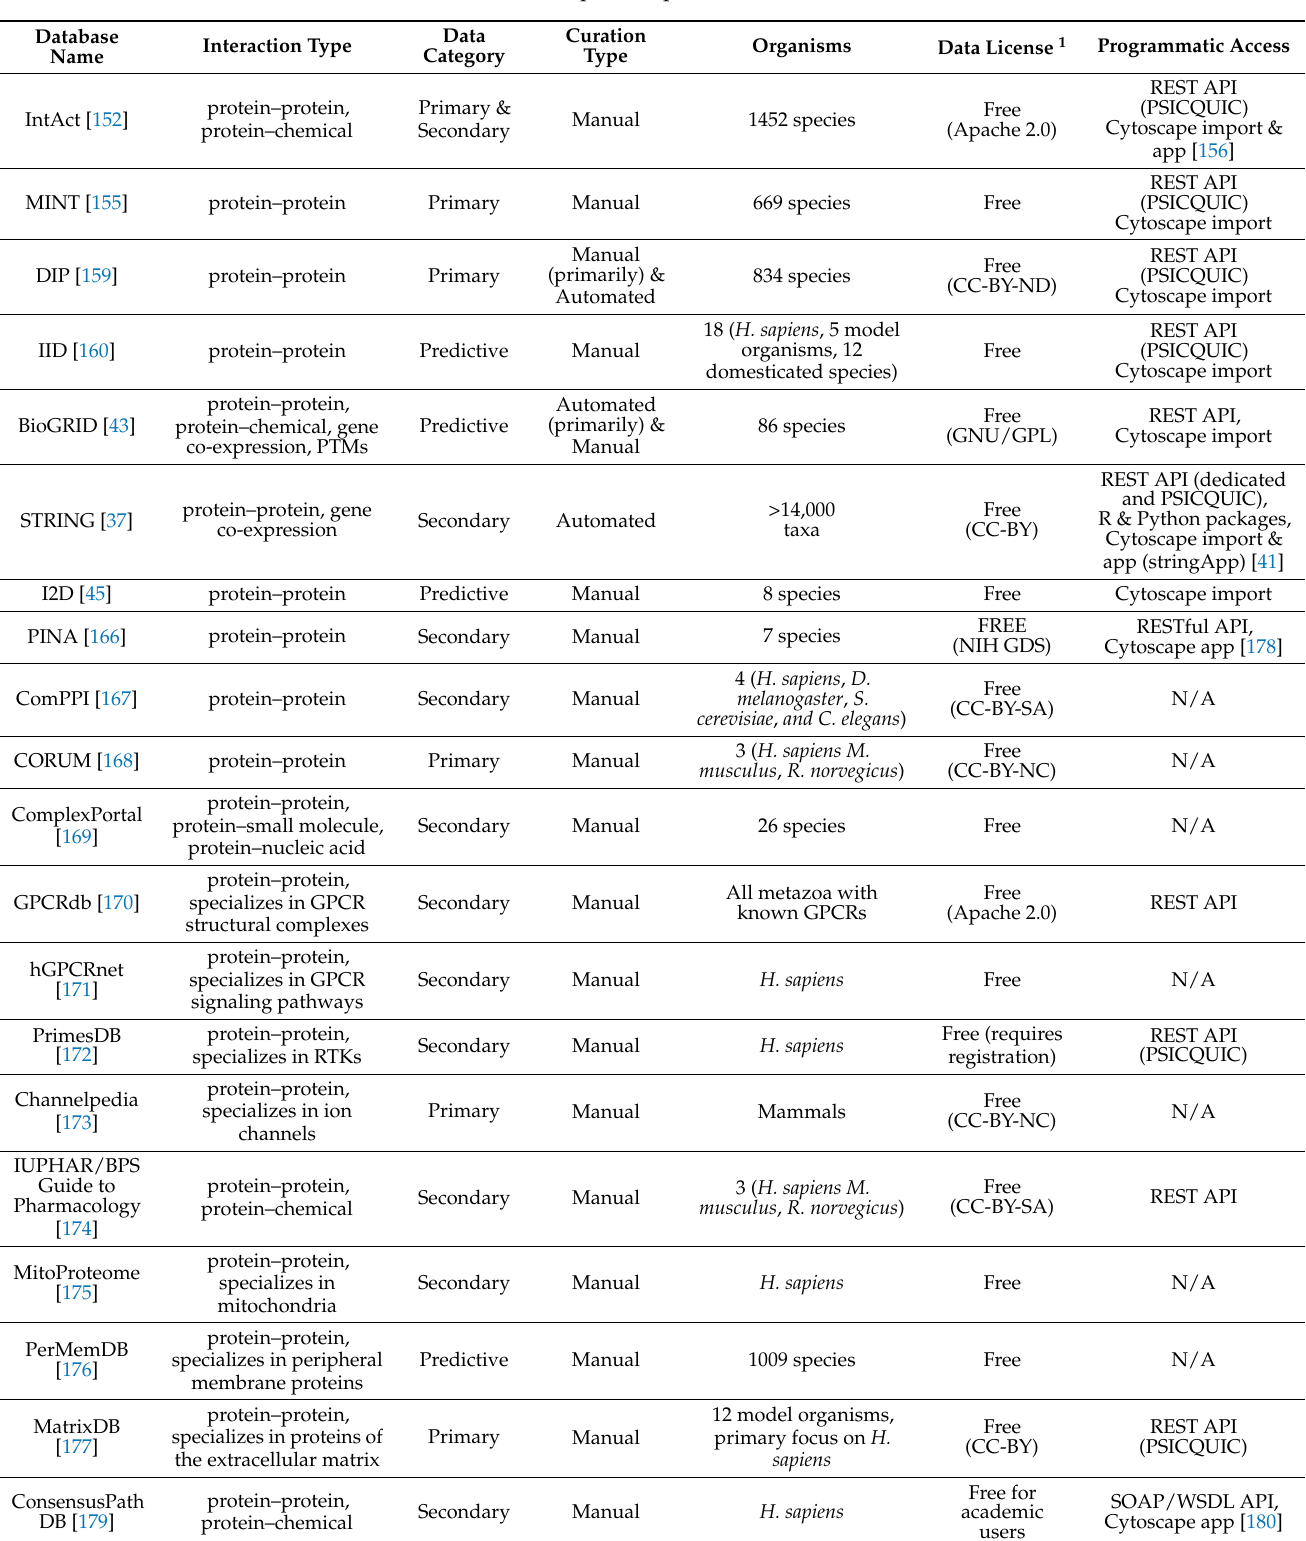
Table 5. A collection of protein–protein interaction